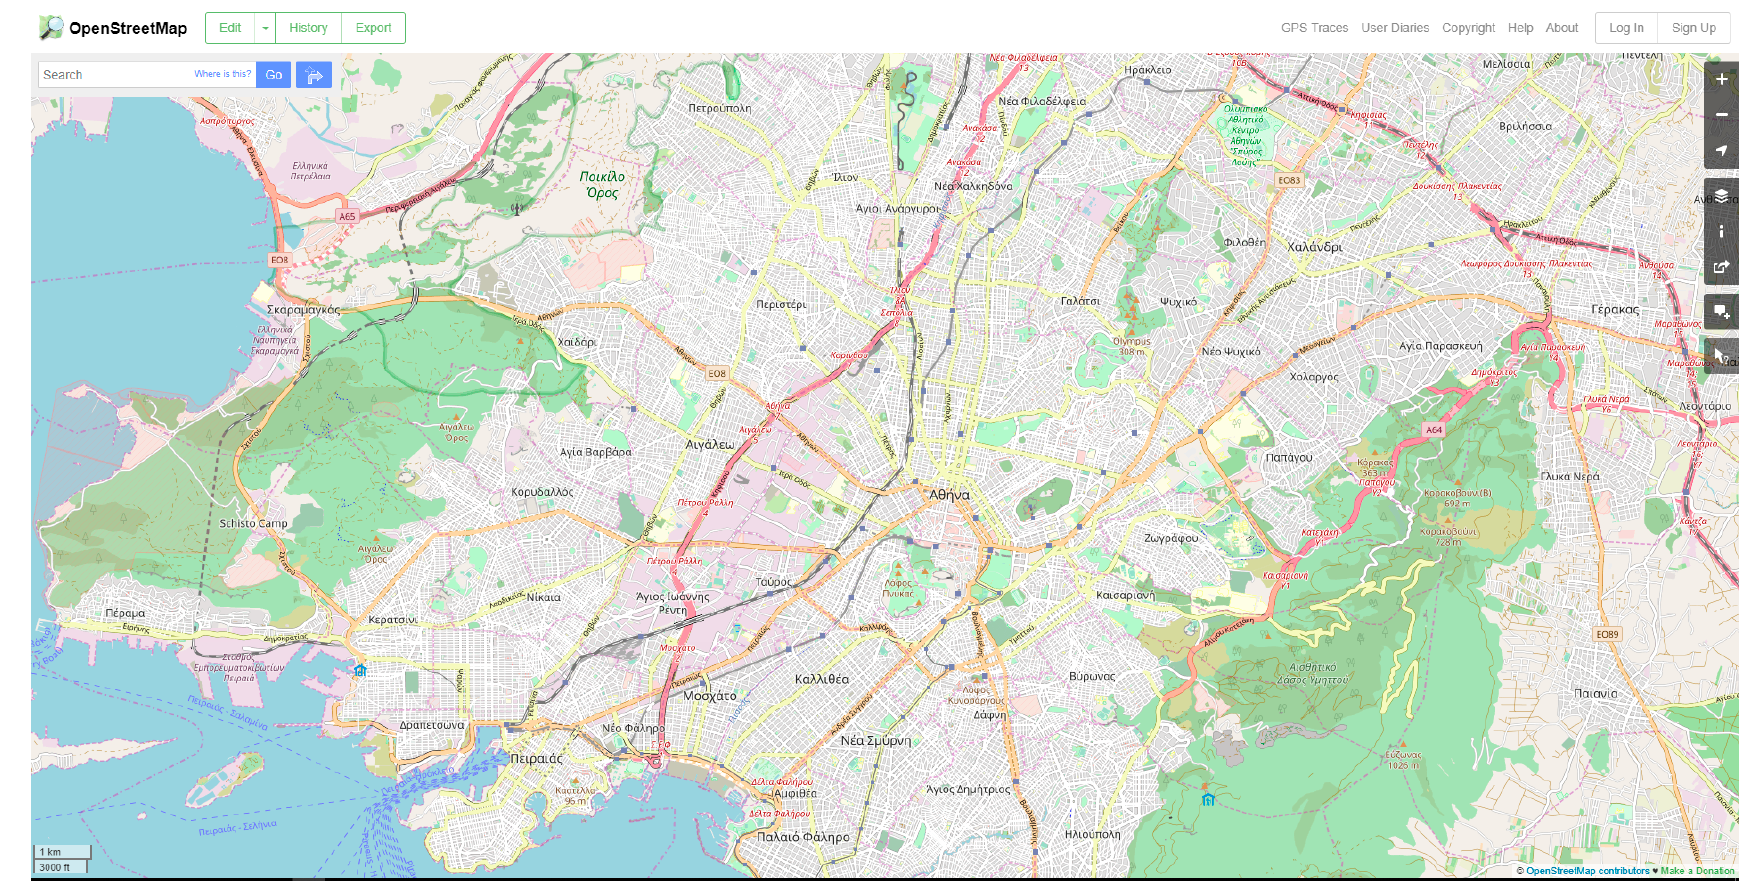
Figure A2. OSM maps (https://www.openstreetmap.org/#map=13/37.9861/23.7160).